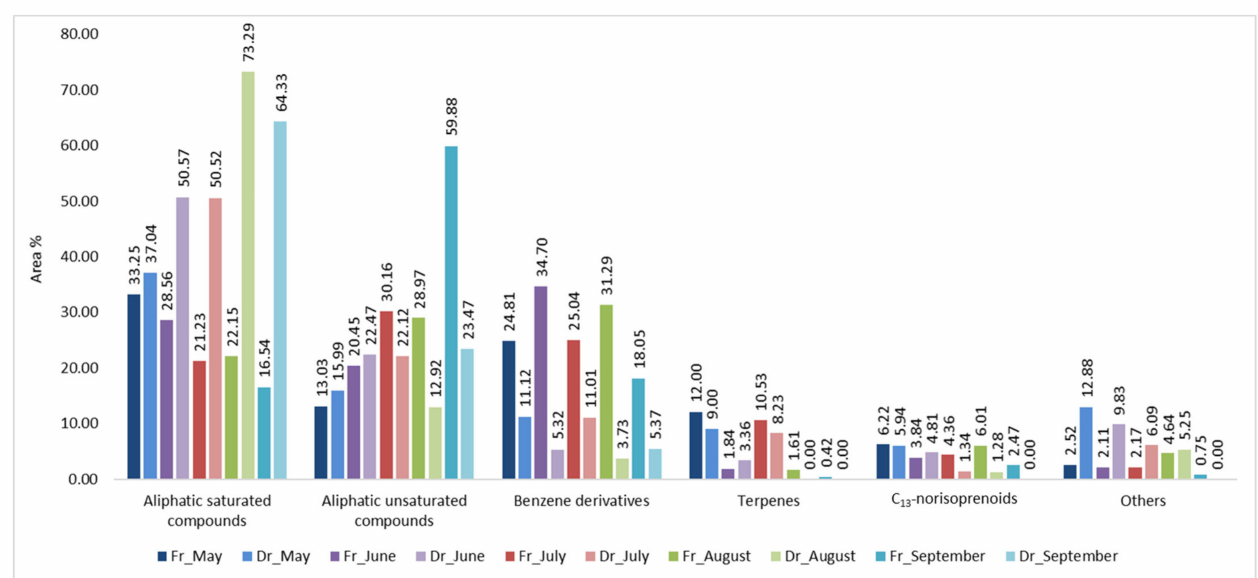
Figure 1. The VOCs from H. scoparia sorted by structural groups extracted by headspace solid-phase microextraction (HS-SPME) and analysed by gas chromatography–mass spectrometry (GC–MS) using DVB/CAR/PDMS fibre (f1); Fr (fresh), Dr